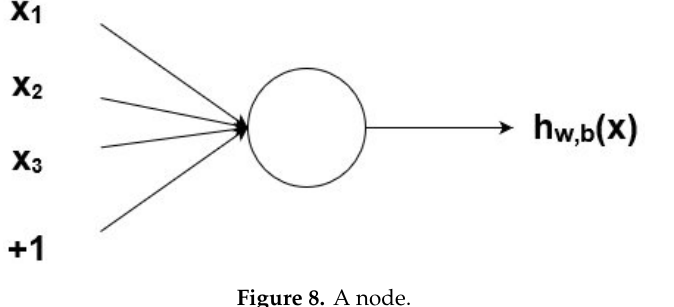
Figure 8. A node. Figure 8. A node.